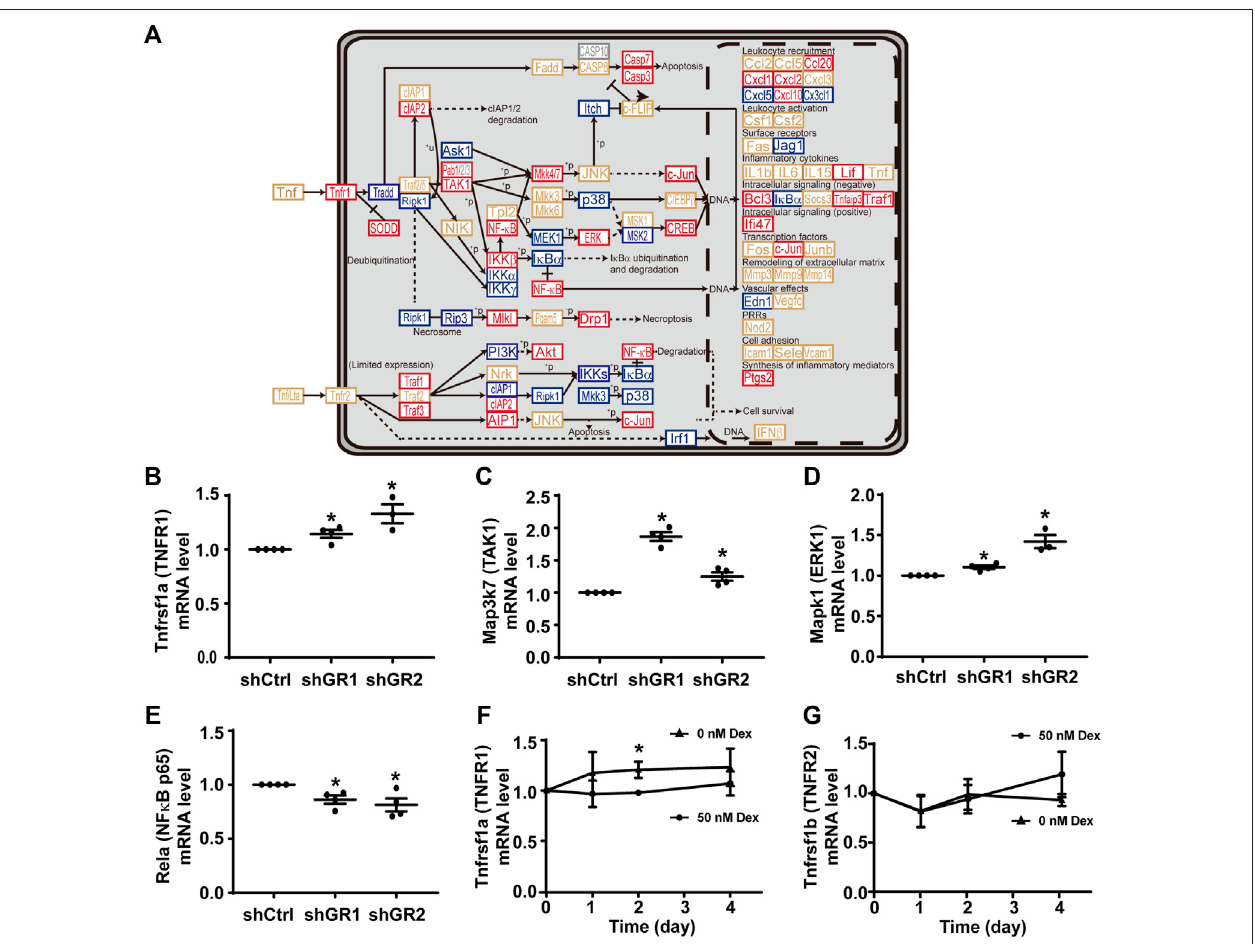
FIGURE 3 | Glucocorticoid receptor knockdown enhanced the KEGG “ TNF signaling pathway ” in the mpkCCD cells. (A) KEGG “ TNF signaling pathway. ” Genes are abbreviated and color-coded: blue, downregulated; gray: not found in the RNA-seq data; red, upregulated; yellow, no change in the glucocorticoid receptor knockdown cells. + P, phosphorylate; − P, dephosphorylate; PRRs, pattern recognition receptors; + u, ubiquitinylate. (B – E) Quantitative RT-PCR measurements of Tnfrsf1a, Map3k7, Mapk1, and Rela mRNA levels in control (shCtrl) and glucocorticoid receptor knockdown (shGR1 and shGR2) cells under vehicle conditions. Values are mean ± S. E. summarized from three or four independent experiments. Asterisks indicate statistical signi fi cance ( p < 0.05, t -test). (F,G) Quantitative RT-PCR measurements of Tnfrsf1a and Tnfrsf1b mRNA levels in polarized mpkCCD cells exposed to 0 vs. 50 nM dexamethasone